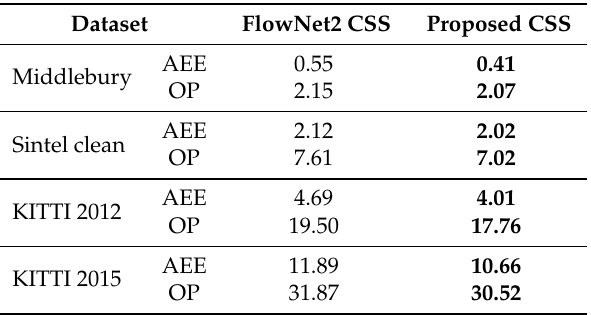
Table 3. FlowNet2 CSS results vs. baseline after the final training step.